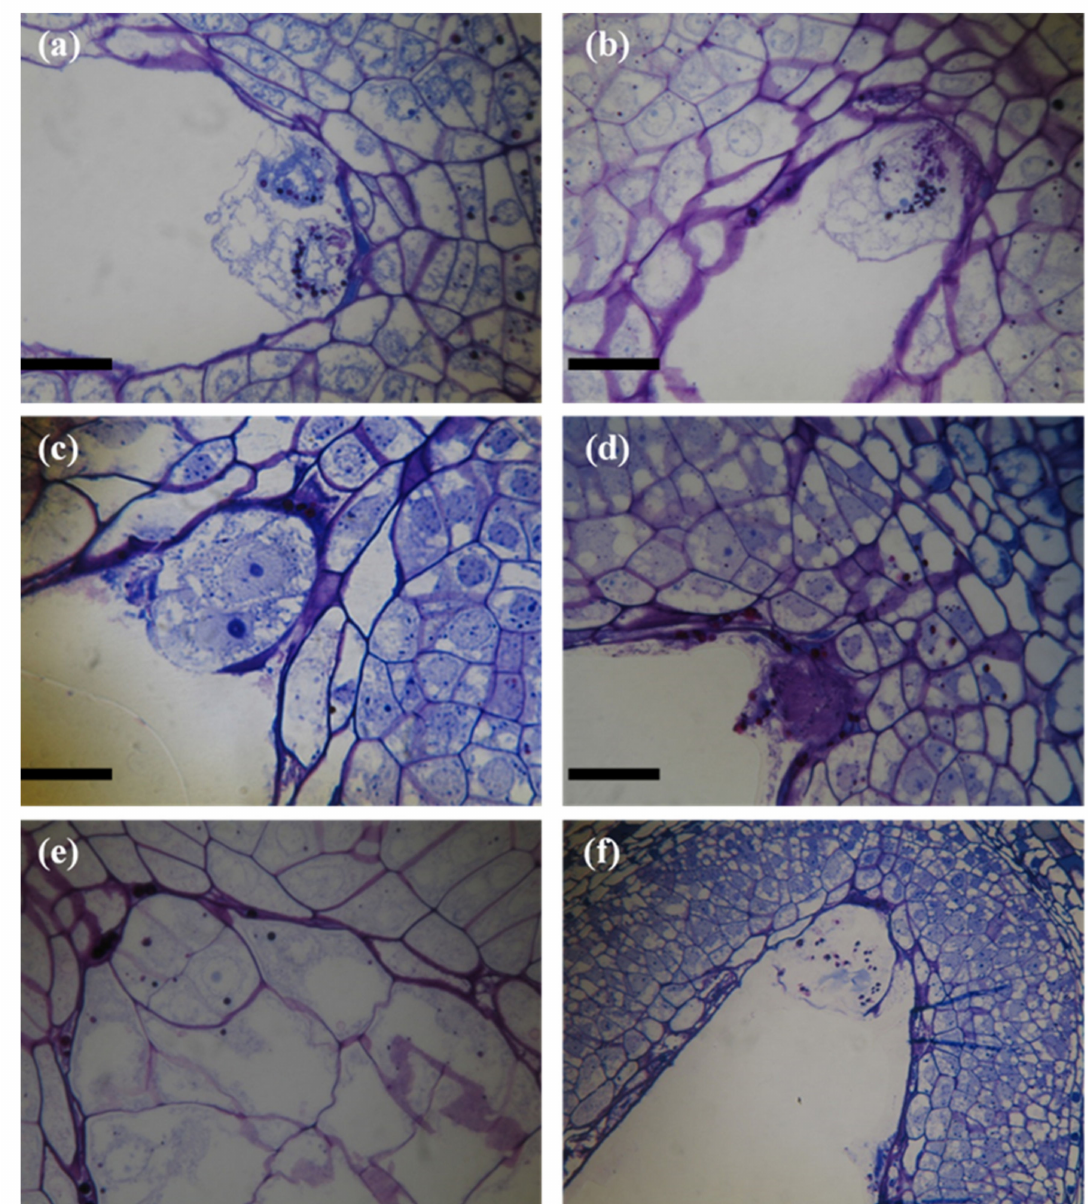
Figure 3. Embryo and endosperm development after pollen deposition on the stigma of avocado flowers at the female and male stages. ( a ) Embryo sac with two synergid cells, with nuclei at the micropilar end, 1 day after pollination at the female stage. ( b ) Synergid cell with the nucleus surrounded by starch grains 1 day after pollination at the male stage. ( c ) Zygote division 10 days after pollination at the female stage. ( d ) No signs of fertilization 10 days after pollination at the male stage. ( e ) Multicellular pro-embryo and multicellular endosperm 16 days after pollination at the female stage. ( f ) Degenerated embryo sac 16 days after pollination at the male stage. Bar =20 µ m. Stain: Pas and toluidine